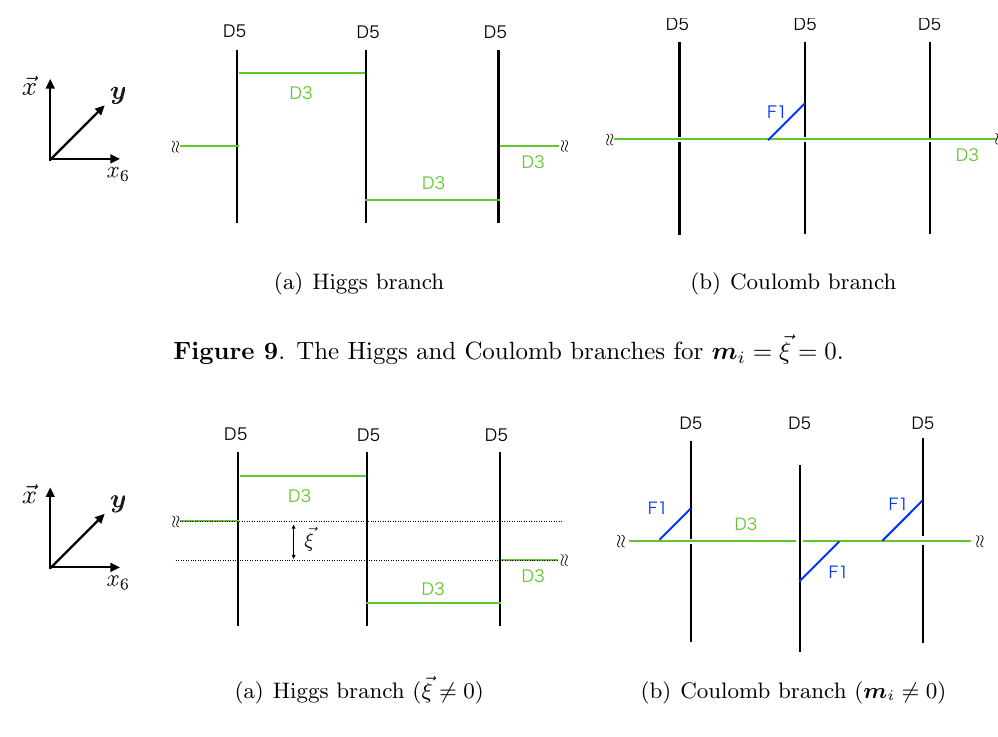
Figure 10 . The Higgs and Coulomb